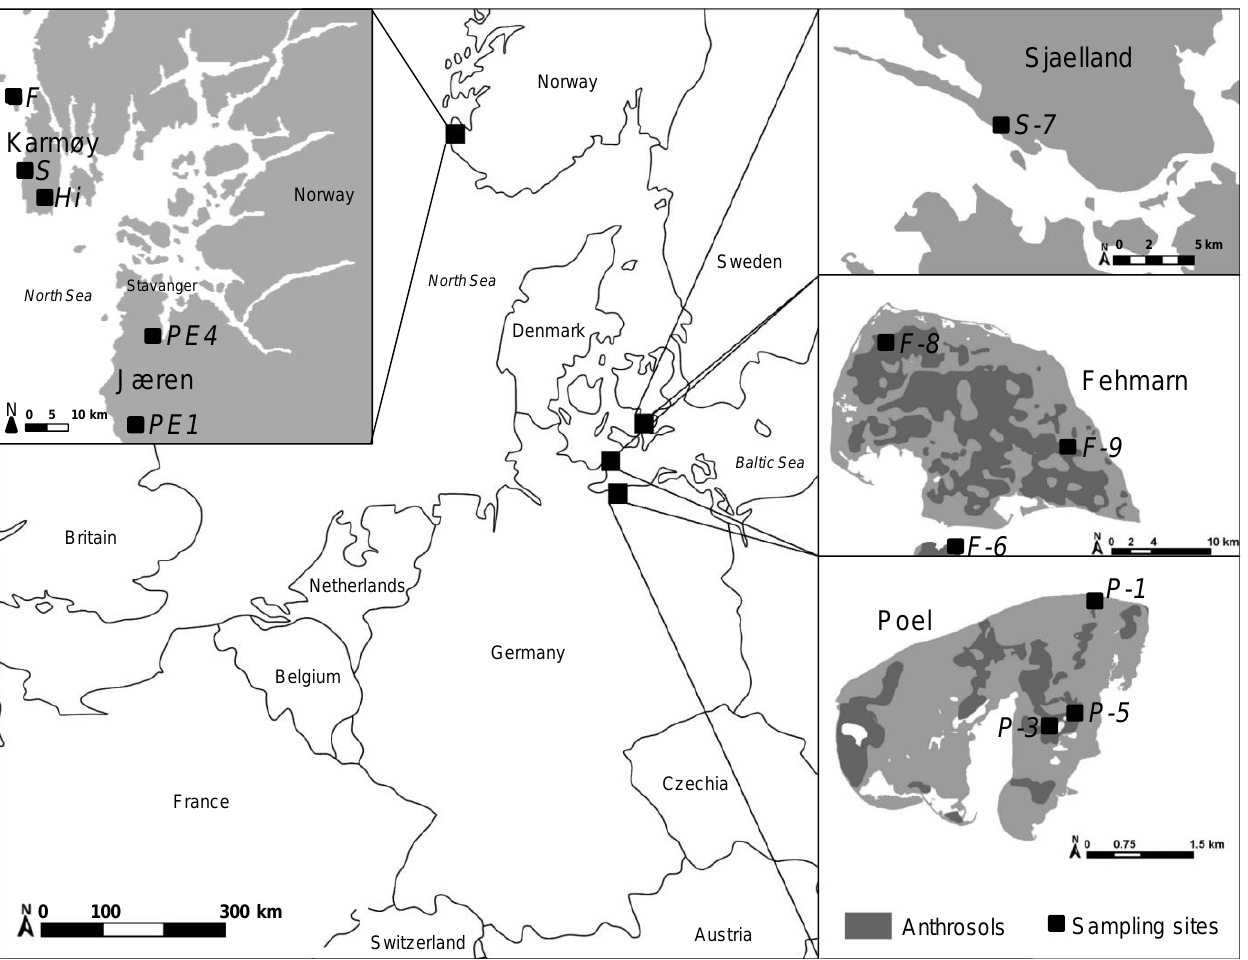
Figure 1. Locations of the Anthrosols at the islands of Poel and Fehmarn in Germany (P-1: Gollwitz; P-3, P-5: Niendorf; F-6: Großenbrode; F-8: Westermarkelsdorf; F-9: Gahlendorf), at the island of Sjaelland in Denmark (S-7: Vordingborg), in the region of Jæren (PE1: Njærheim; PE4: Årsvoll), and at the island of Karmøy and Feøy in Norway (Hi: Hillesland; S: Sandhåland; F: Feøy).